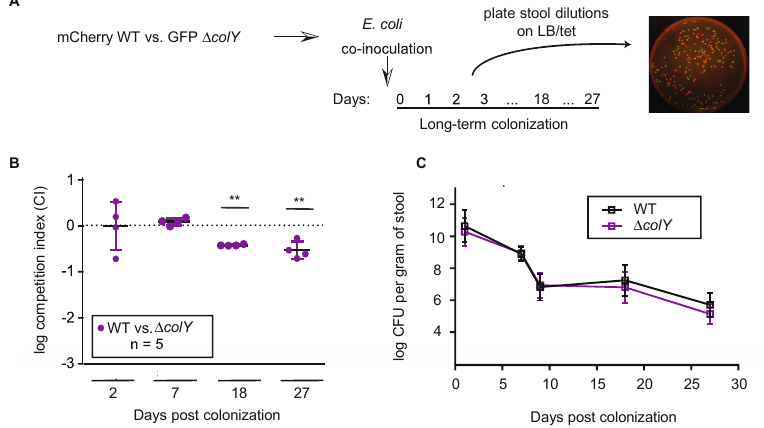
Figure 3. Competition of ∆ colY in the adult mouse gastrointestinal tract. ( A ) Schematic of the competition protocol. Mice were inoculated in a 1:1 ratio of either strain and fecal samples were collected at various days post-inoculation. Fecal samples were serially diluted and plated onto LB / tetracycline plates. A representative plate is shown. ( B , C ) Groups of 6- to 8-week-old C57BL / 6 mice were co-inoculated. ( B ) Log competitive index (CI) was calculated by taking the ratio of the output colonies normalized to the input ratio. Each circle represents one specific animal. ( C ) CFU counts per gram of feces for the competition experiment. Each square represents the mean and standard deviation from all individual mice. Limit of detection was 10 2 . Significant p values are noted (** p > 0.005) and were calculated using a one sample t-test. If colonies were too numerous to count on a plate, the corresponding animal was excluded from the data for that